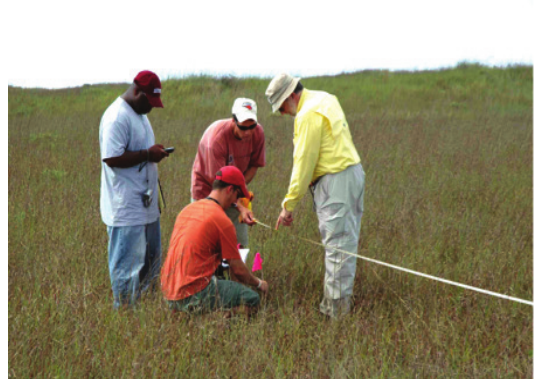
Figure 2. Members of iGETT Cohort 2 use GPS units in a ground based Exercise in Landsat data validation.